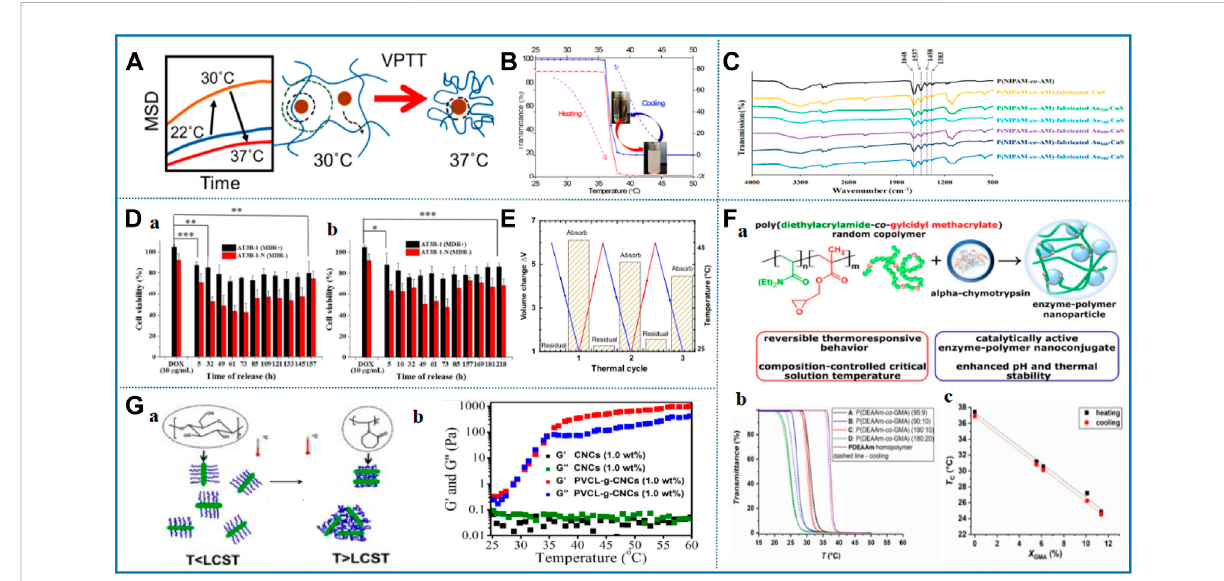
FIGURE 3 Representative studies of thermosensitive nanomaterials based on amide. (A) Temperature-dependent nanoparticle dynamics in poly (N-isopropylacrylamide) gels. Reprinted with permission from Parrish et al. (2018) Copyright © 2018 American Chemical Society (B) Temperature responsiveness of the three-component nanohybrid (Au@mSi@P). Reprinted with permission from Baek et al. (2016). Copyright © 2016 American Chemical Society (C) FTIR spectrum of P(NIPAM-co-AM) temperature-sensitive nanomaterial. Reprinted with permission from Chang et al. (2018). Copyright © 2018 American Chemical Society. (D) In vitro anticancer activities were evaluated using the MTT assays of thermoresponsive hydrogel formed by alginate-g-poly (N-isopropylacrylamide). Reprinted with permission from Liu M. et al (2017). Copyright © 2017 American Chemical Society (E) PNIPAm-POSS copolymer volume change during thermal cycles. Reprinted with permission from Romo-Uribe and